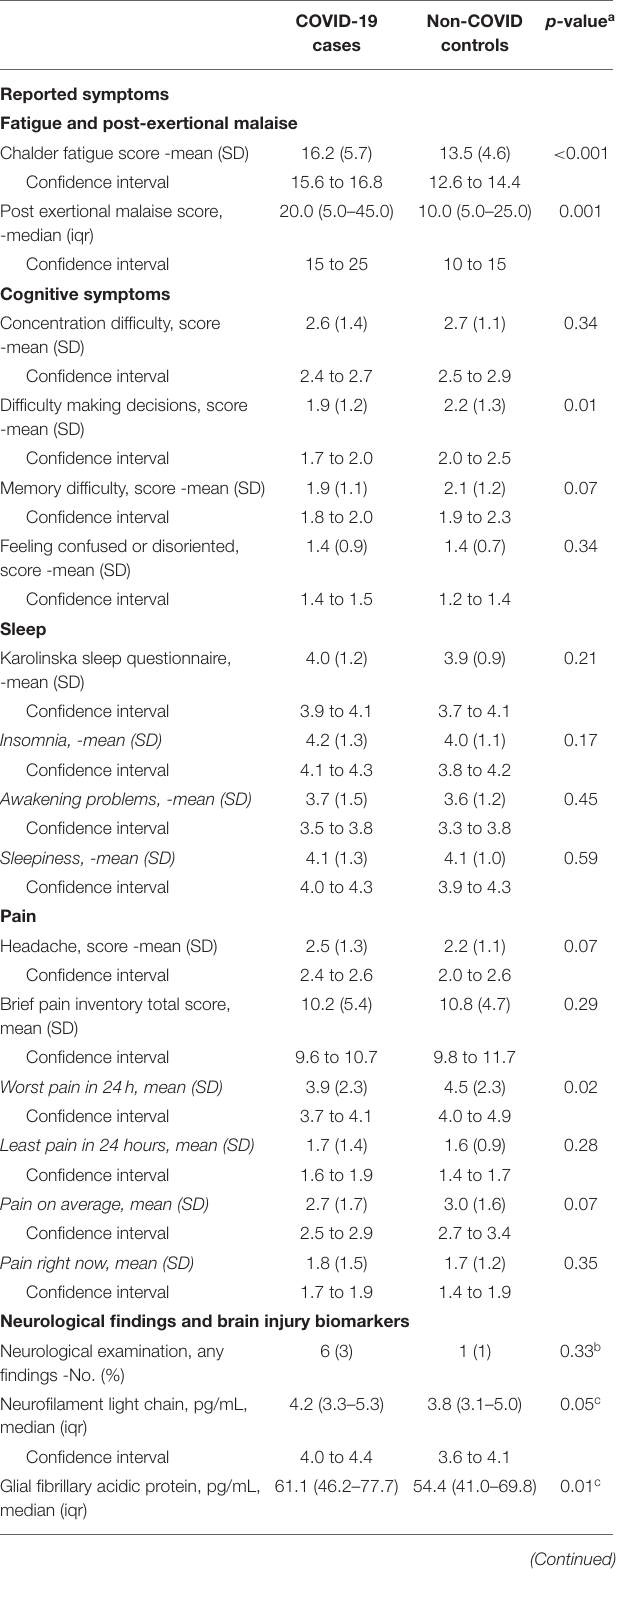
p- value COVID-19 Non-COVID cases controls